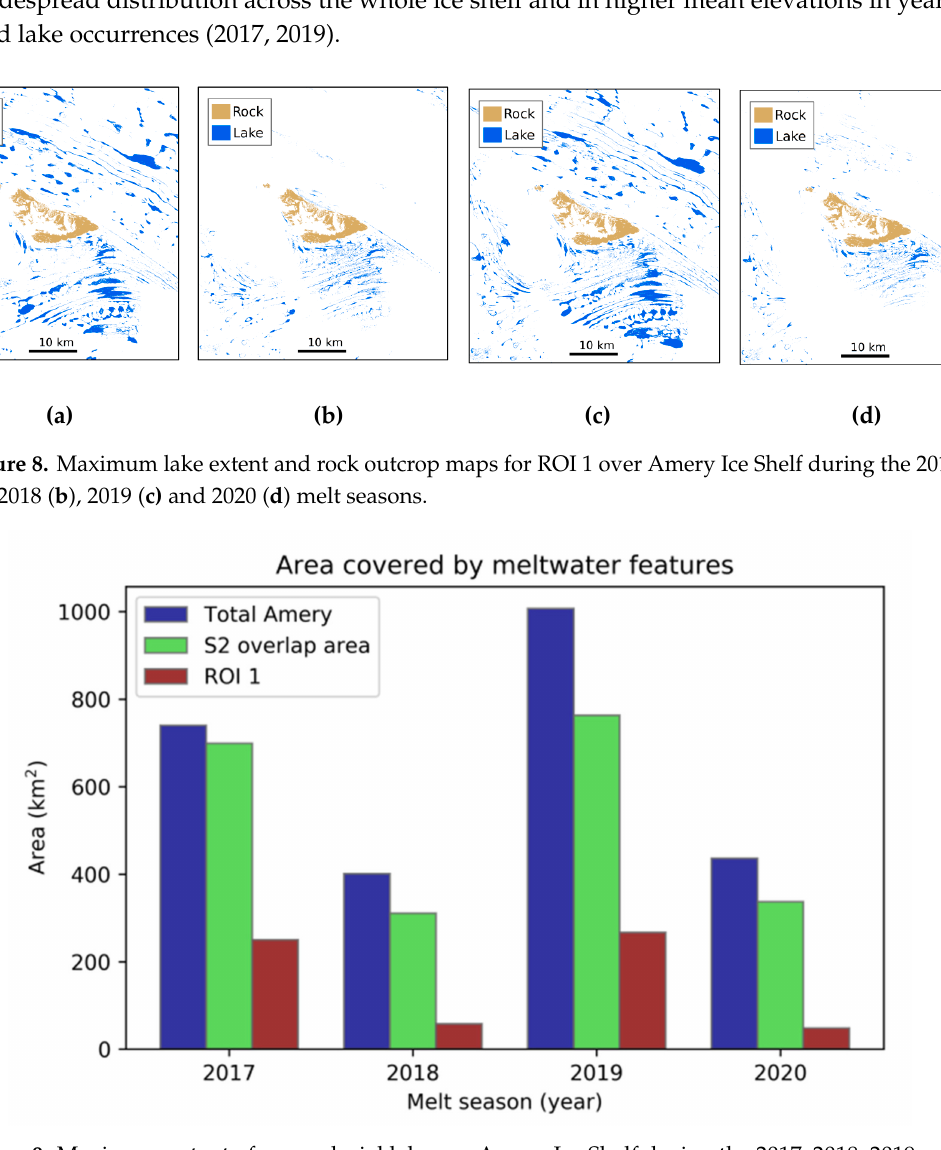
Figure 9. Maximum extent of supraglacial lakes on Amery Ice Shelf during the 2017, 2018, 2019 and 2020 melt seasons with respect to the total coverage of Sentinel-2 acquisitions for each year (blue), their respective overlap region (green) as well as ROI 1 (red).